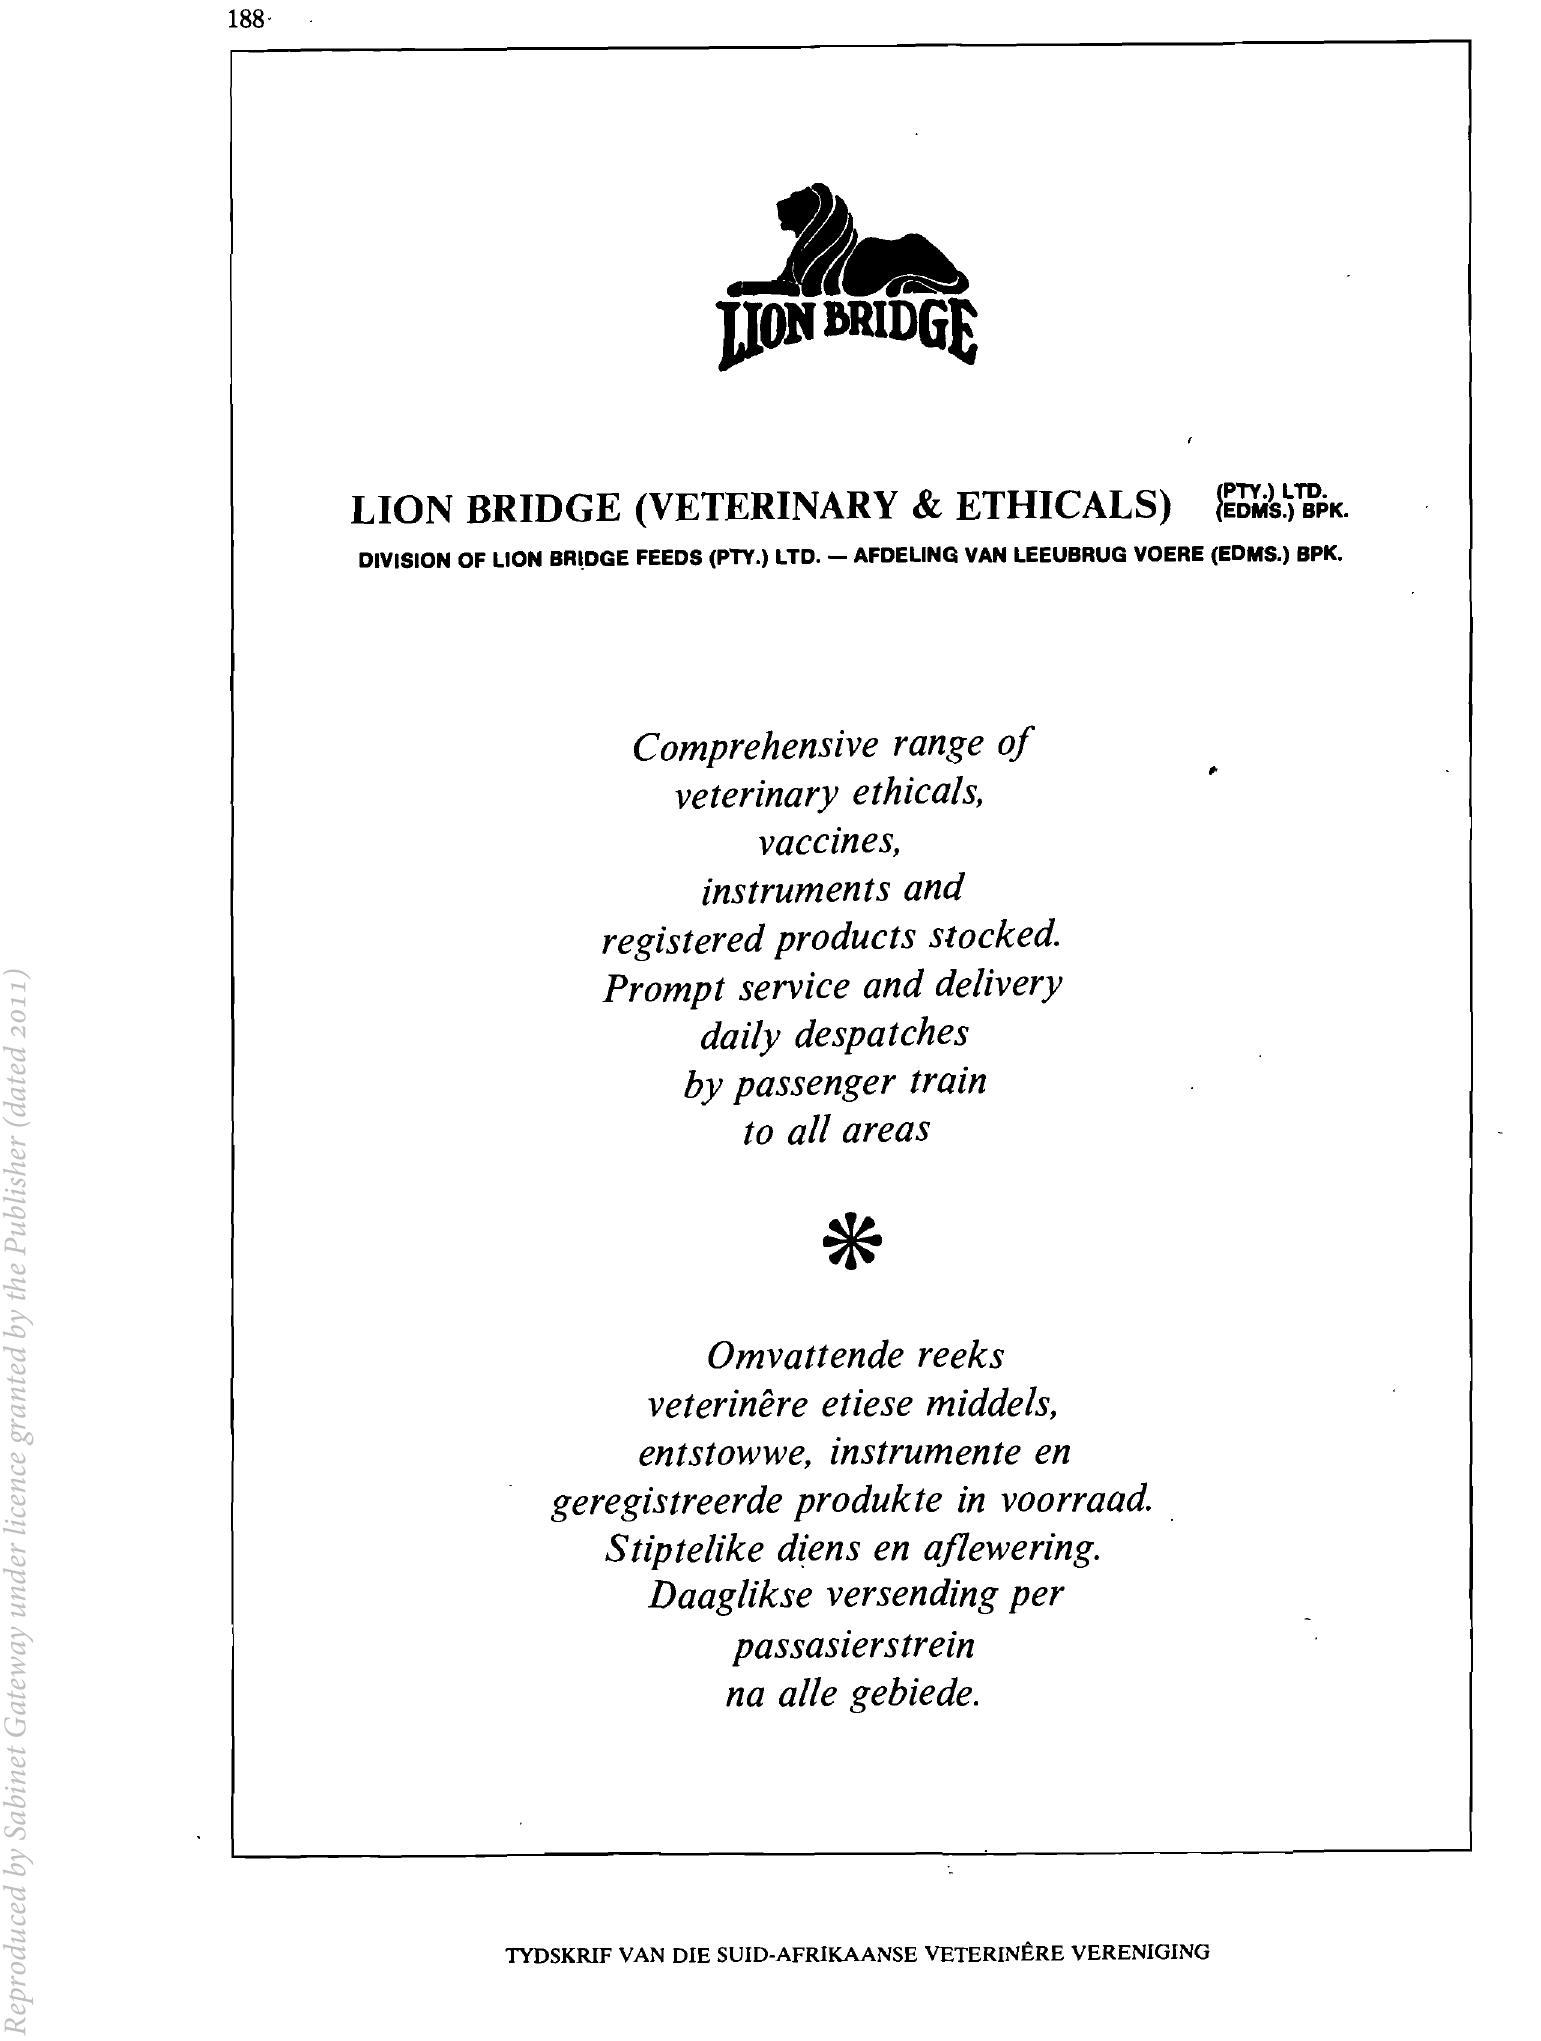
geregistreerde produkte in voorraad. Stiptelike diens en aflewering. Daaglikse versending per passasierstrein na aile